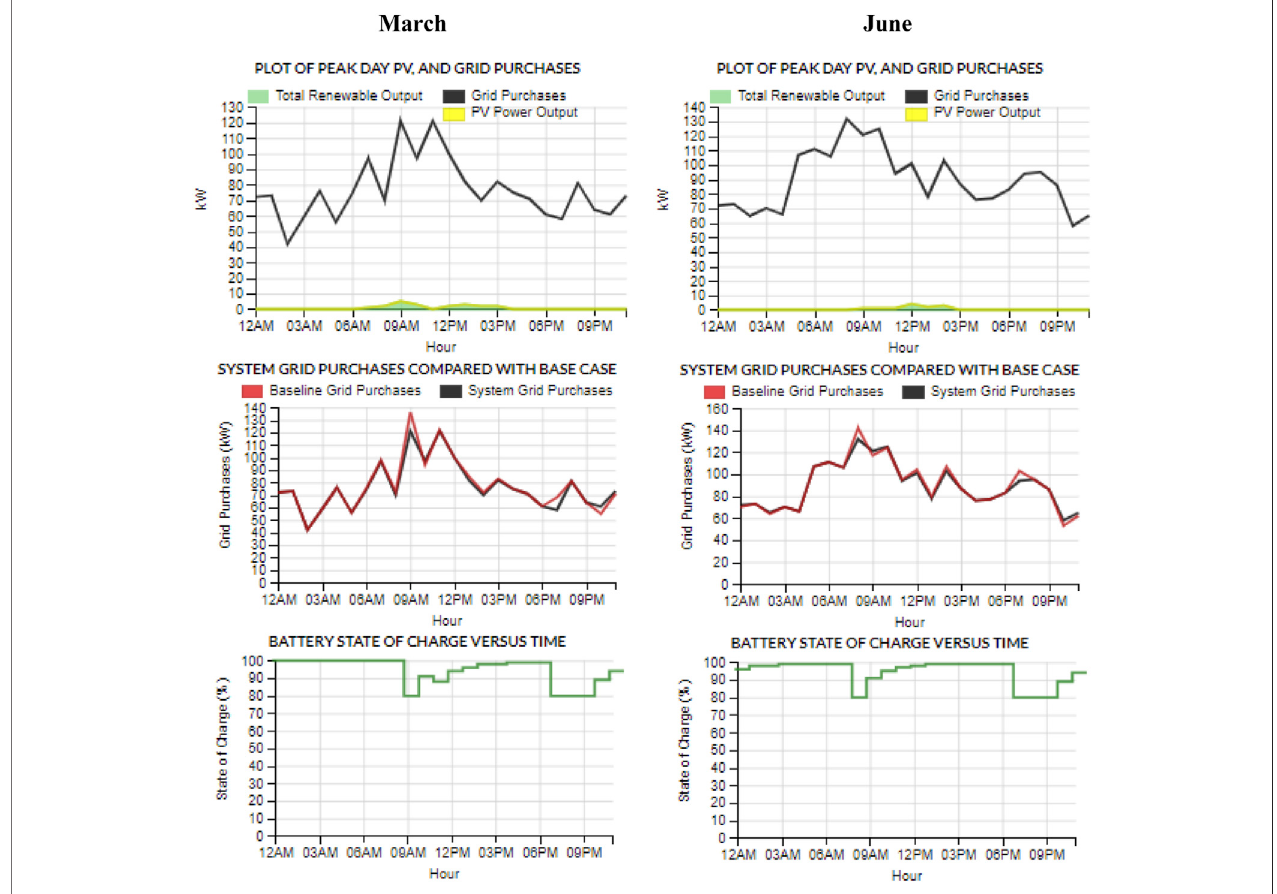
FIGURE 10 | The Homer Grid simulation results for the pilot project for the Neoville headquarters in March and June. Data Sources: the authors.